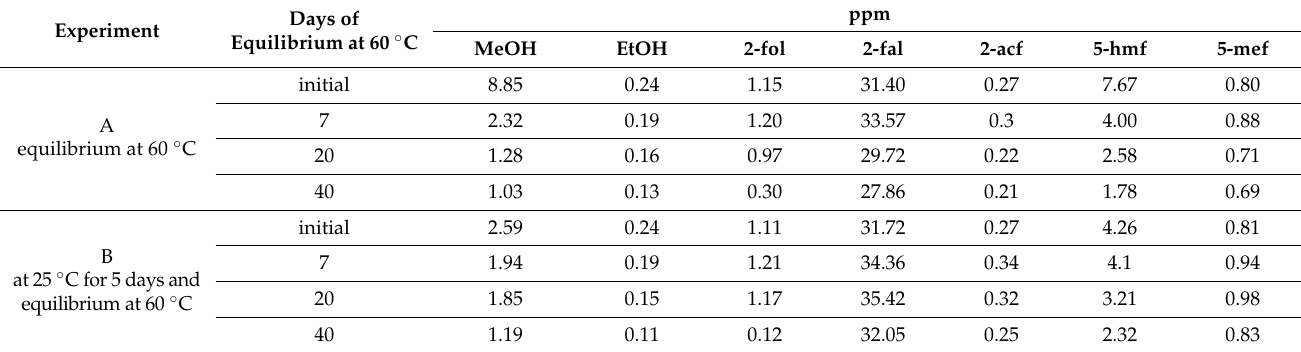
Table 7. Changes of concentrations of alcohols and furans during equilibrium at 60 ◦